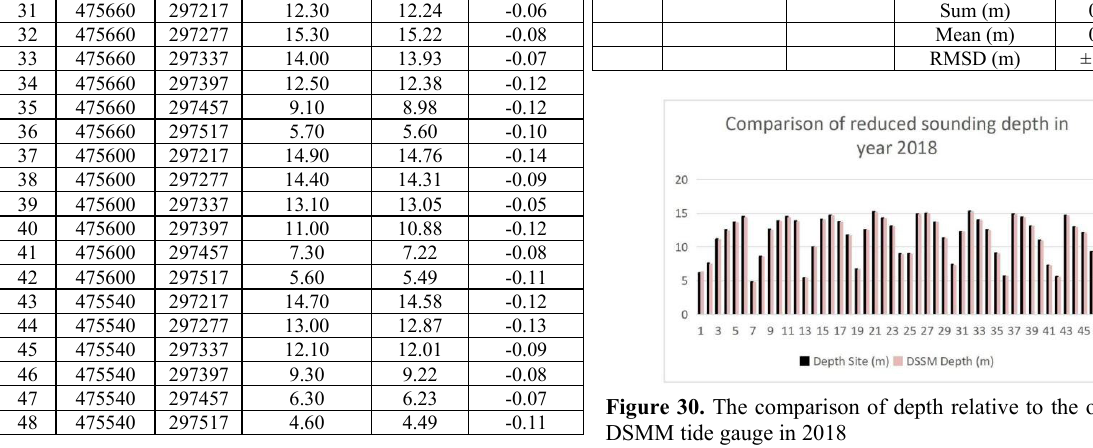
Table 9. RMSD between the reduced sounding depth relative to on-site and DSMM tide gauge in 2018 No.